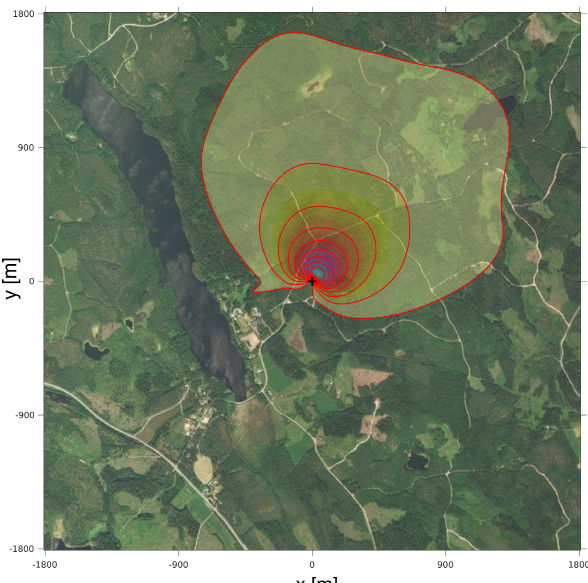
Figure B2. The footprint of the O 2 and CO 2 surface fluxes at 53.6m height (which is the geometric height), determined with the gradient method for the days during 7 through 12 July 2019 at Hyytiälä. The lines and contours indicate the contributions to the footprint from 10% to 90% in steps of 10%. The plus sign (+) indicates the location of the tower. This figure was created with the method by Kljun et al.